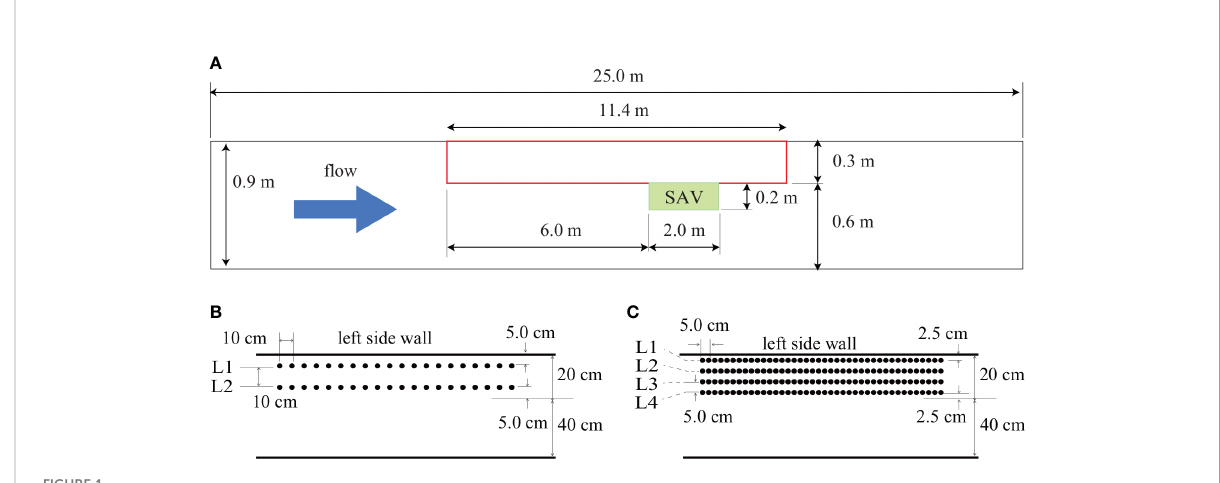
FIGURE 1 Open channel tank in the laboratory experiment. (A) The SAV replica was installed in the green-highlighted area. The SAV intervals were (B) 0.10 m and (C) 0.05 m.